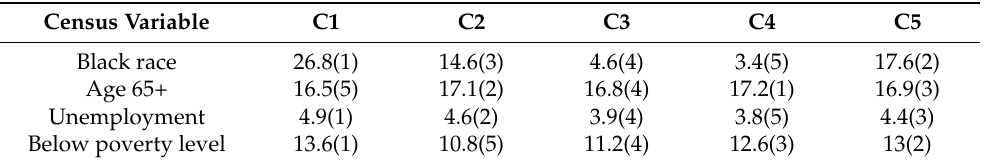
Table 2. Characterization (in terms of median and rank) of the seven groups of COVID-19 death patterns across the 51 US states using four risk factors from 2019 US census